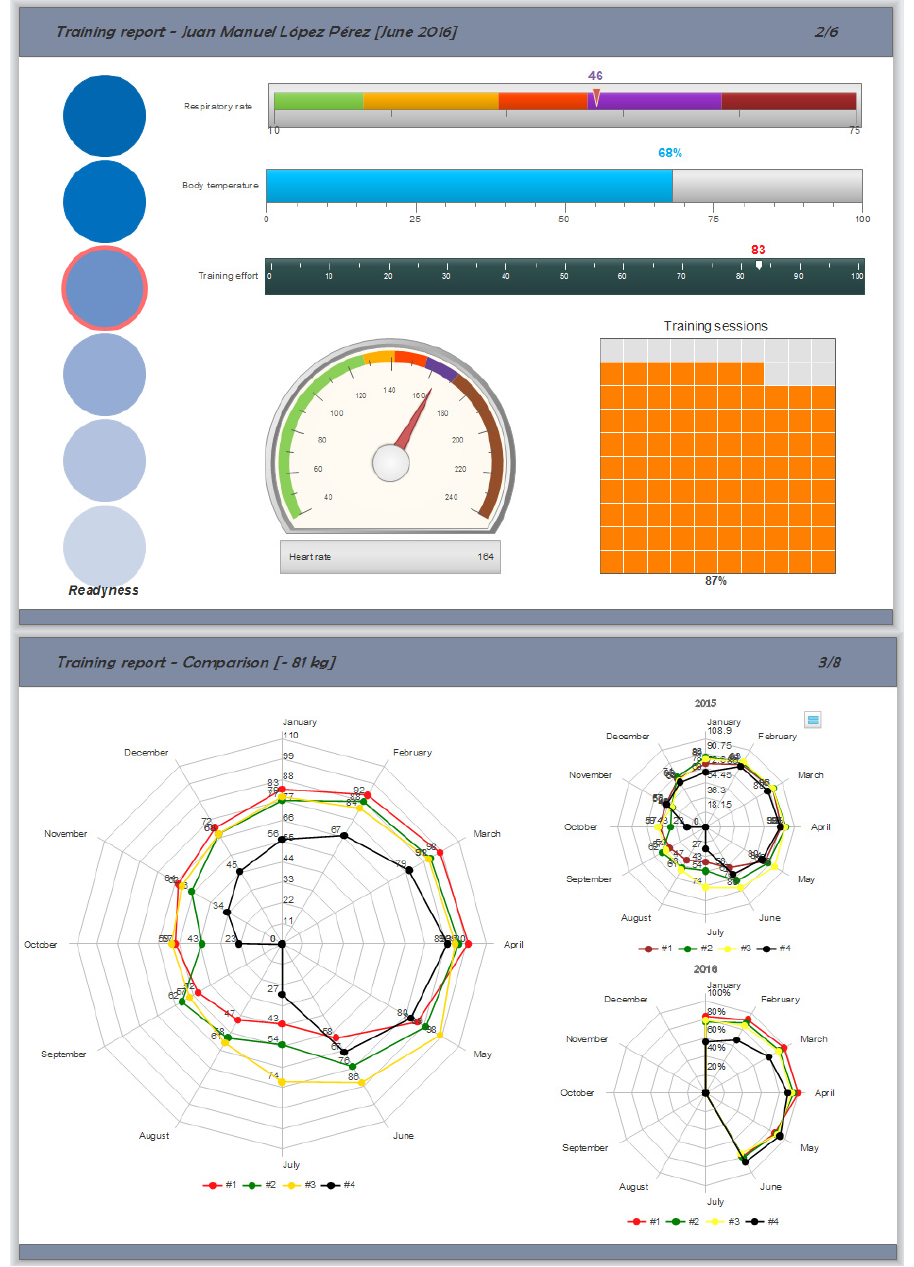
Figure 22. Reporting examples: individual report ( top ) and collective report by category ( bottom ).